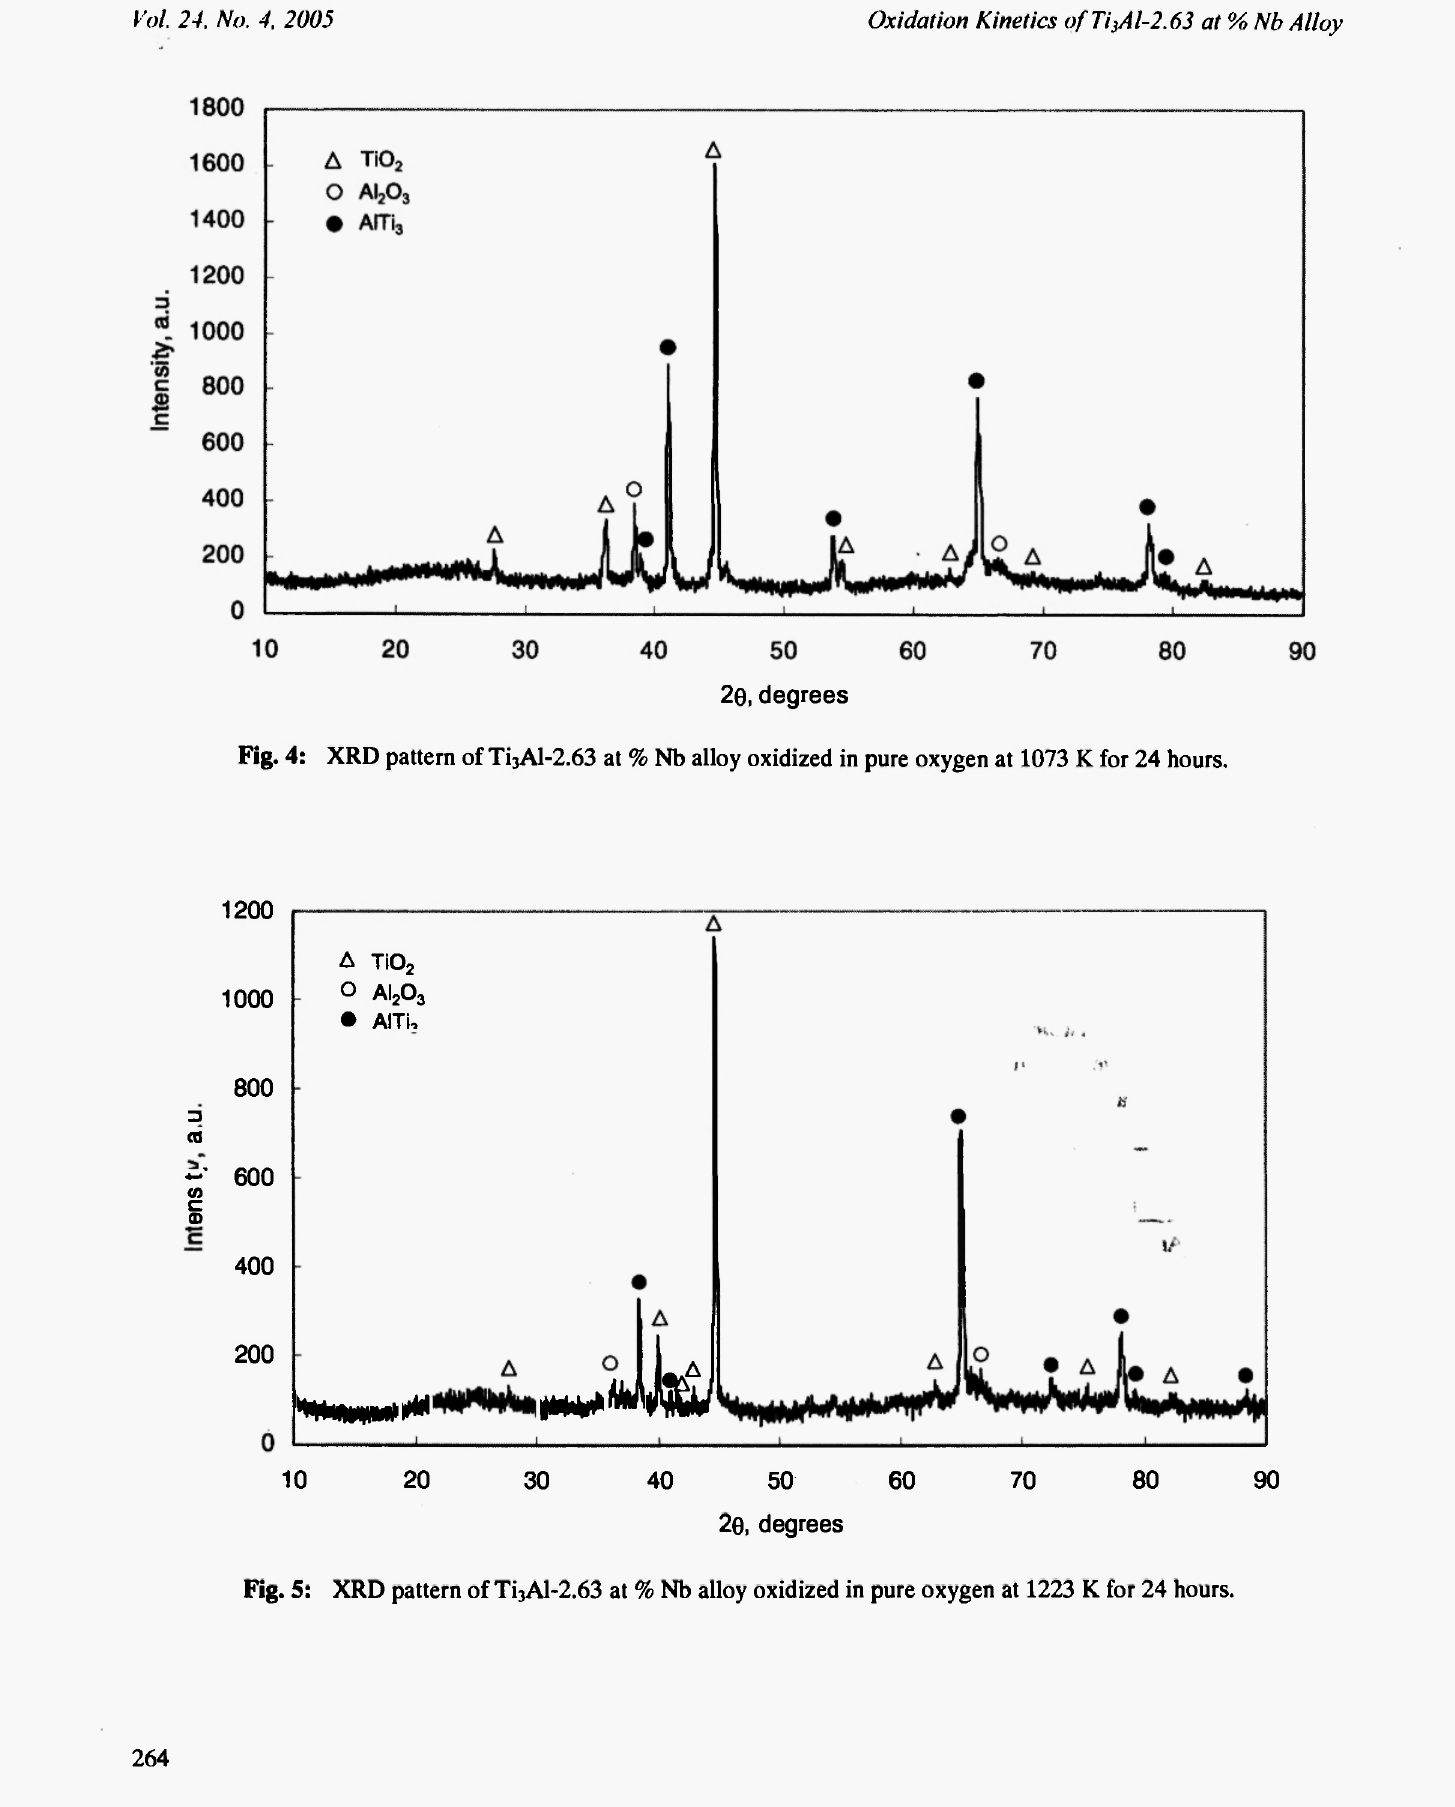
Fig. 5: XRD pattern of Ti 3 Al-2.63 at % Nb alloy oxidized in pure oxygen at 1223 Κ for 24